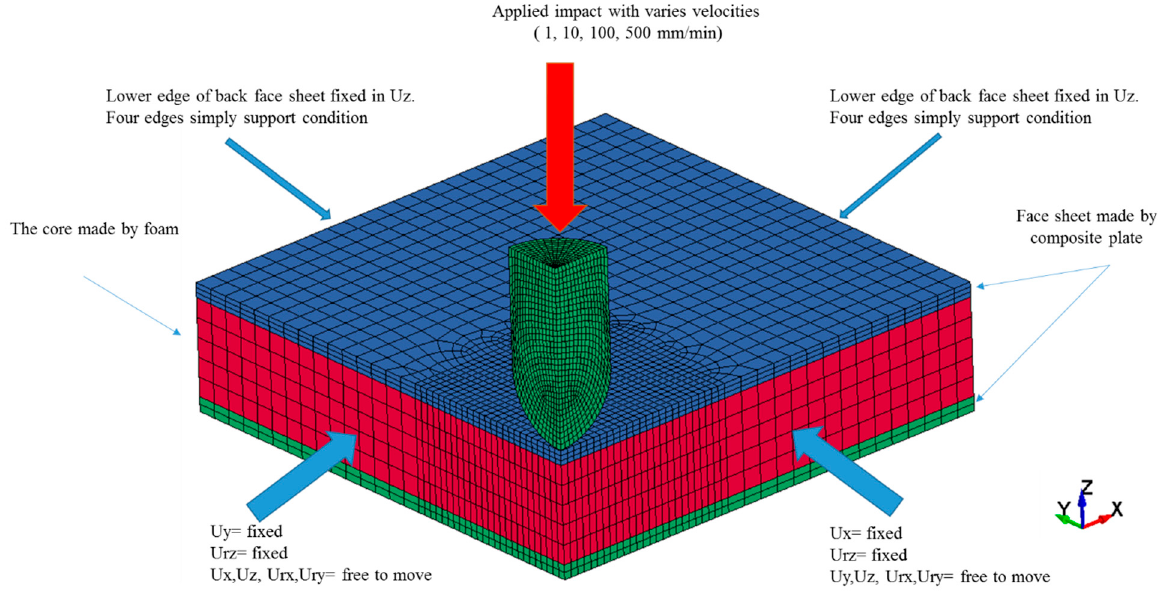
Figure 6. Boundary conditions and applied load to a quarter FE model.